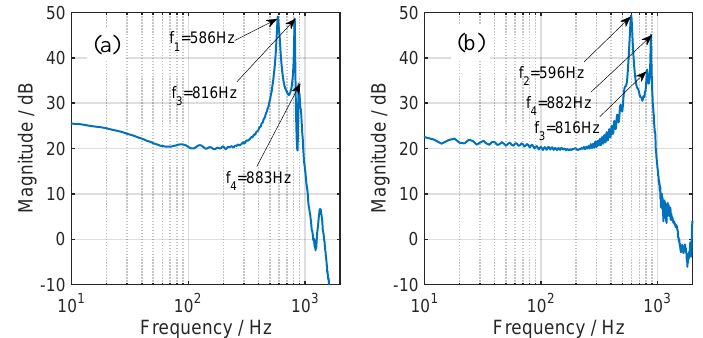
Figure 12. The amplitude response function of ( a ) the x -axis and ( b ) the y